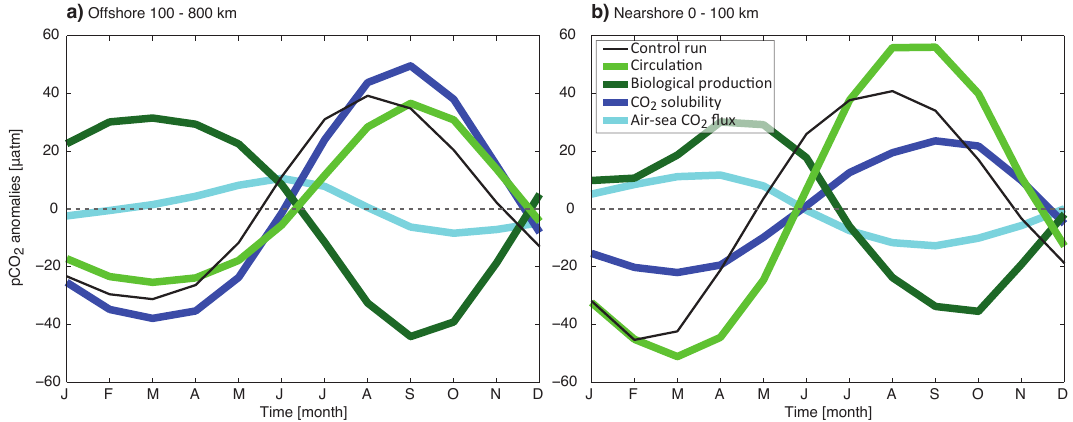
Fig. 10. Monthly mean p CO 2 anomalies for the offshore (a) and the nearshore (b) domains: the colored lines represent the contributions of ocean circulation, biological production, CO 2 solubility and air–sea CO 2 flux to monthly mean p CO 2 anomalies from the control simulation (black